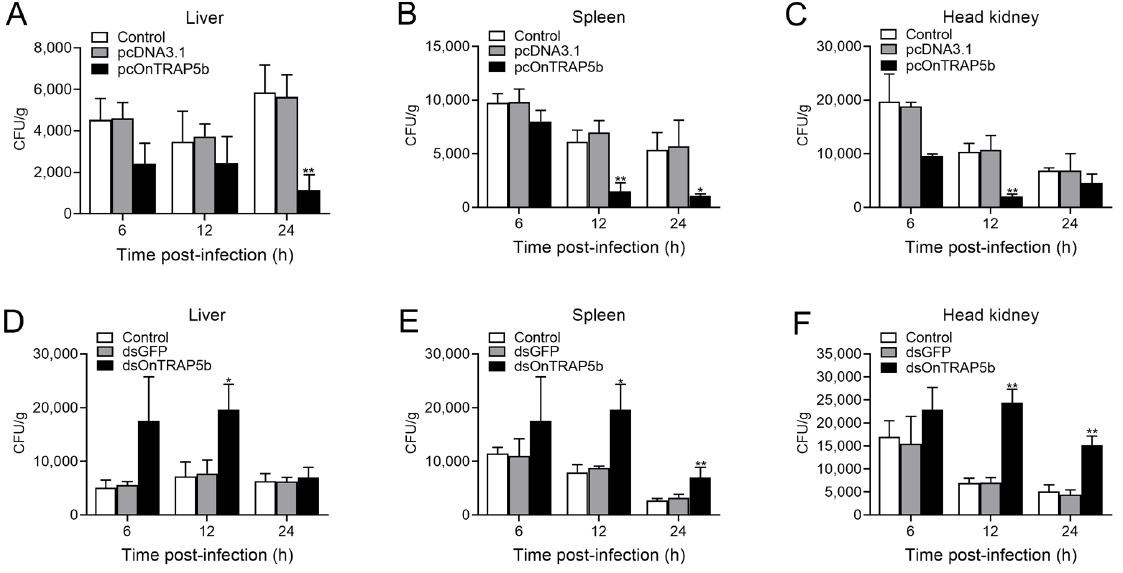
Figure 9. Analysis of the effects of overexpression and knockdown expression of OnTRAP5b on S. agalactiae infection. Nile tilapia administered with pcOnTRAP5b, pcDNA3.1, dsOnTRAP5b, dsGFP, or PBS (control) were infected with S. agalactiae . Bacterial loads in the liver ( A , D ), spleen ( B , E ), and head kidney ( C , F ) at 6, 12, and 24 h after S. agalactiae infection were determined. The values are shown as means ± SD ( n = 3), n , the number of times the experiments were performed. ** p < 0.01, * p <